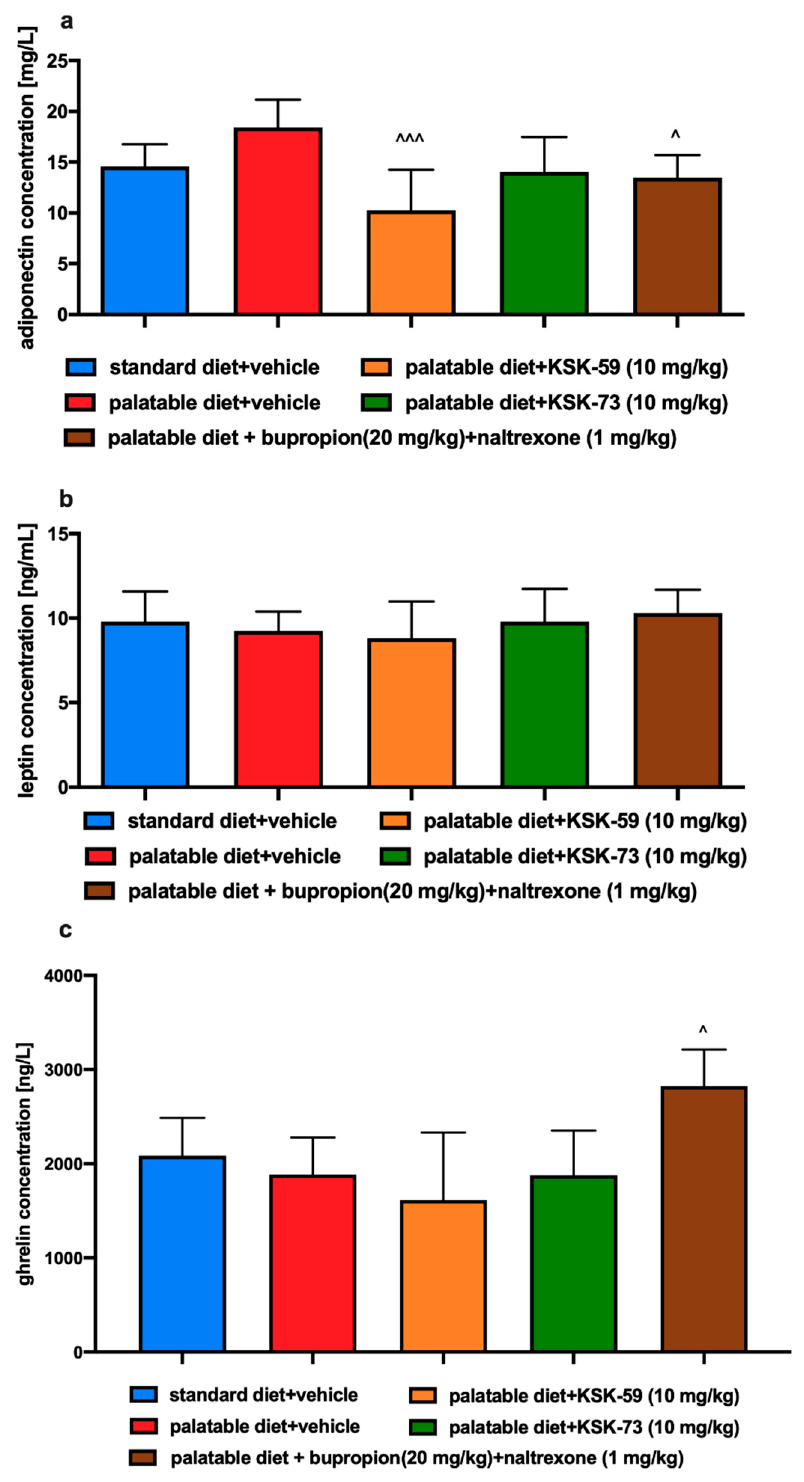
Figure 7. Effect of administration of the tested compound or bupropion/naltrexone on levels in plasma of: ( a ) adiponectin, ( b ) leptin, and ( c ) ghrelin. Results are expressed as means ± SEM, n = 6. Comparisons were performed by one-way ANOVA, Tukey’s post hoc test; ˆ significant against control rats fed palatable diet; ˆ p < 0.05, ˆˆˆ p <